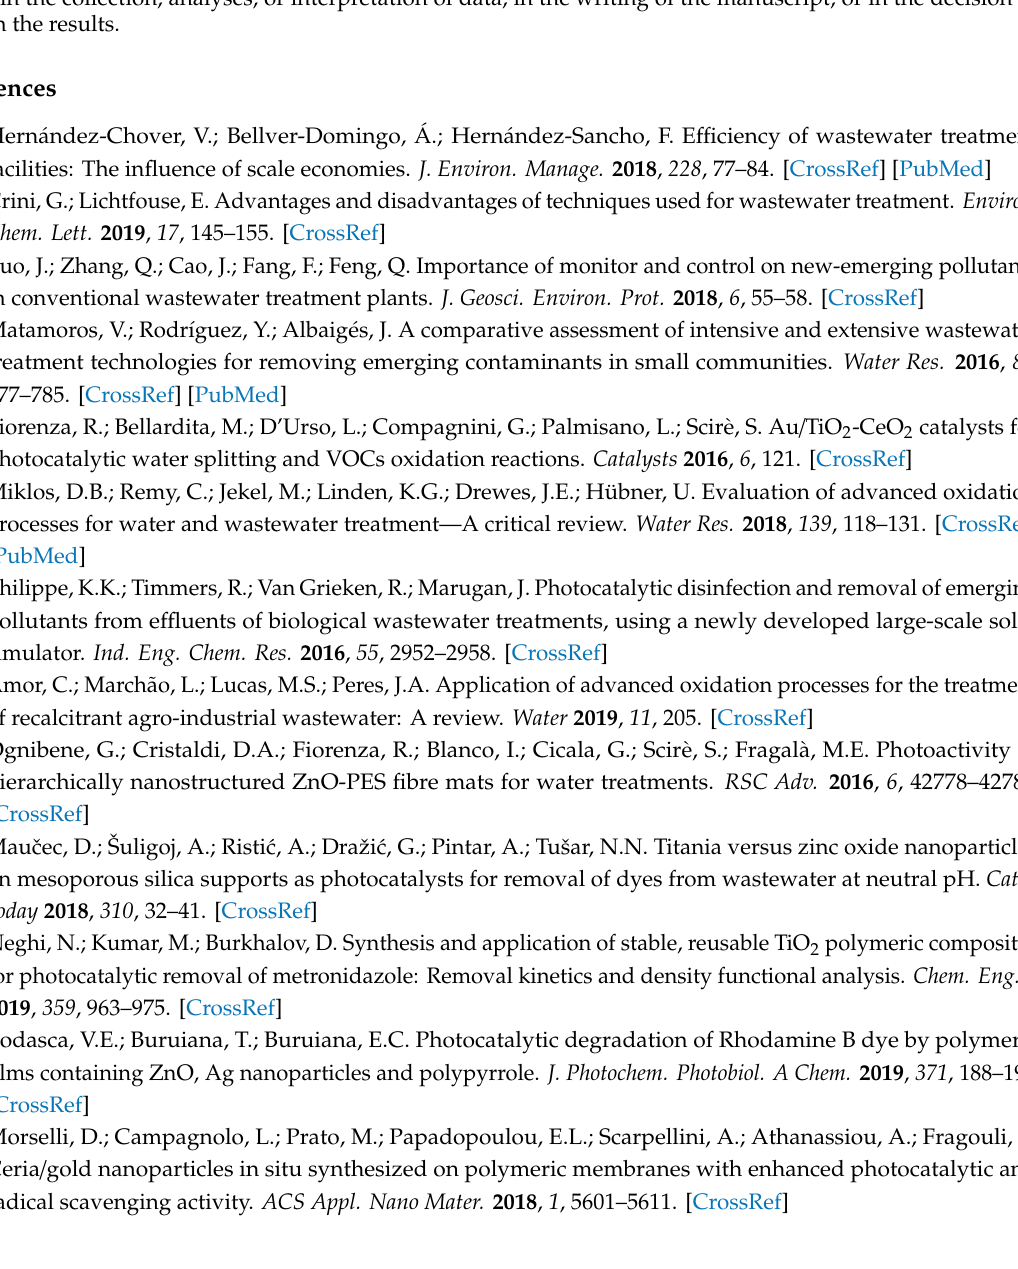
Table S3: Photo-degradation rate constants and linear regression coe ffi cients obtained from the linear fitting of the experimental data by using the pseudo-first order model. Figure S10: Photocatalytic degradation activity of ( a ) MB and ( b ) BPA for three consecutive UV irradiation cycles using PMMA / ZnO composite